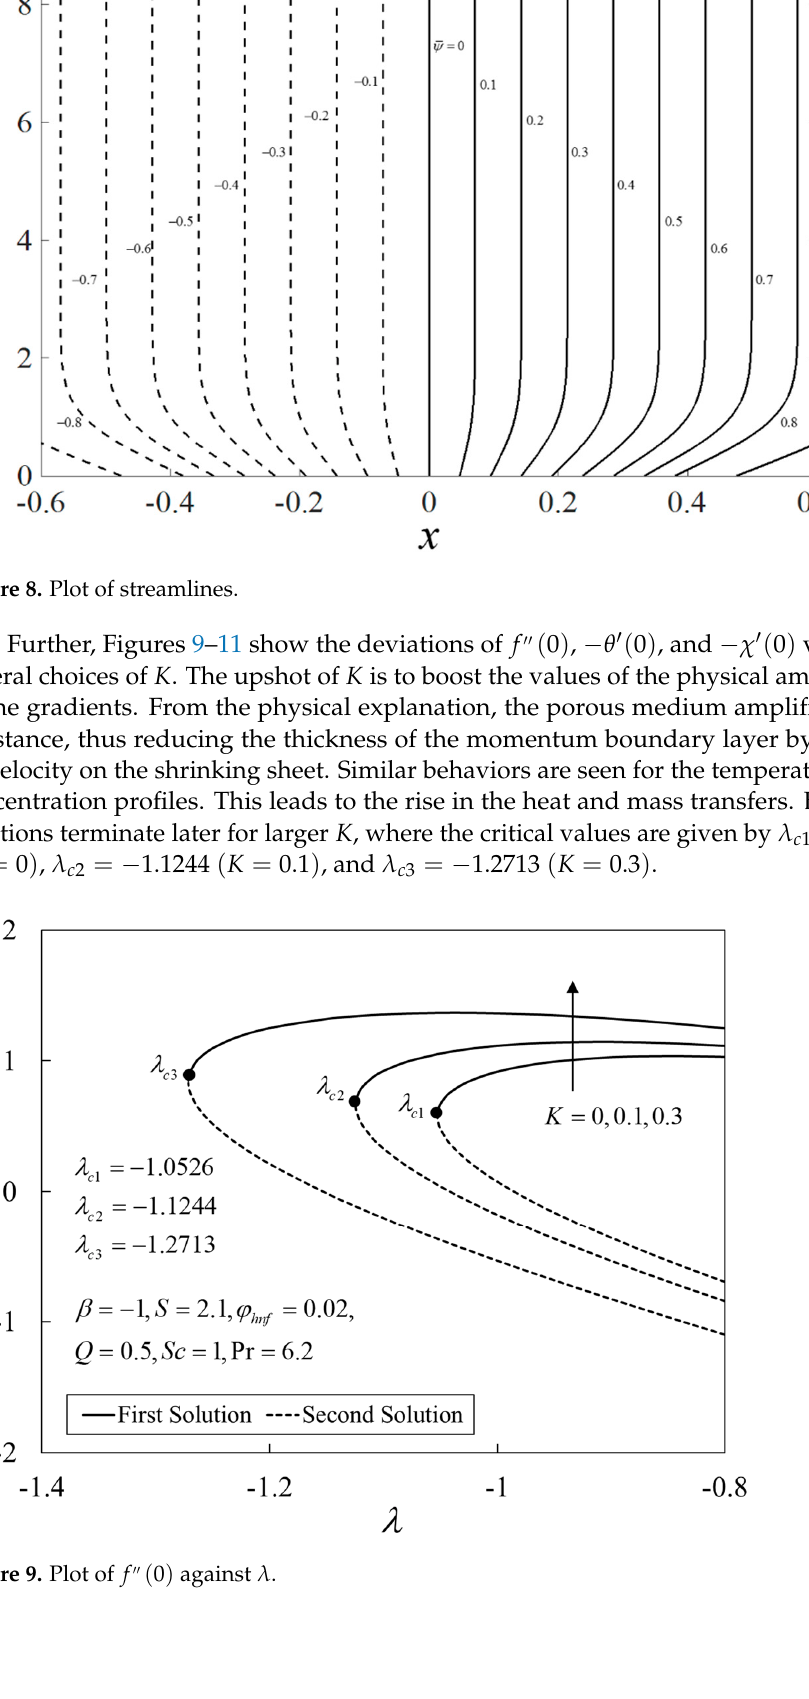
Figure 10. Plot of (0)  against  .